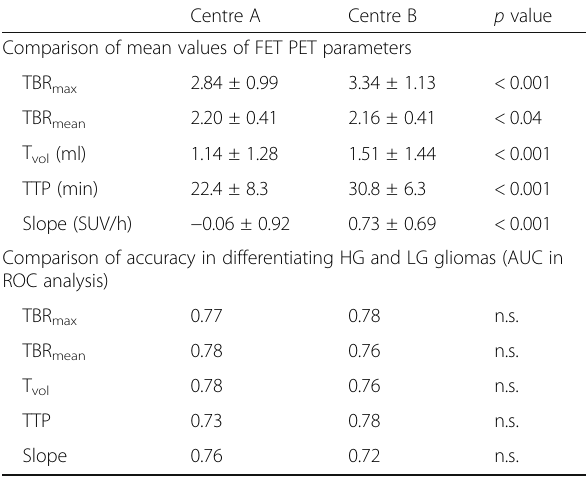
Table 2 Comparison of 18 F-FET parameters in centre A and centre B based on the same data set Centre A Centre B p value Comparison of mean values of FET PET parameters